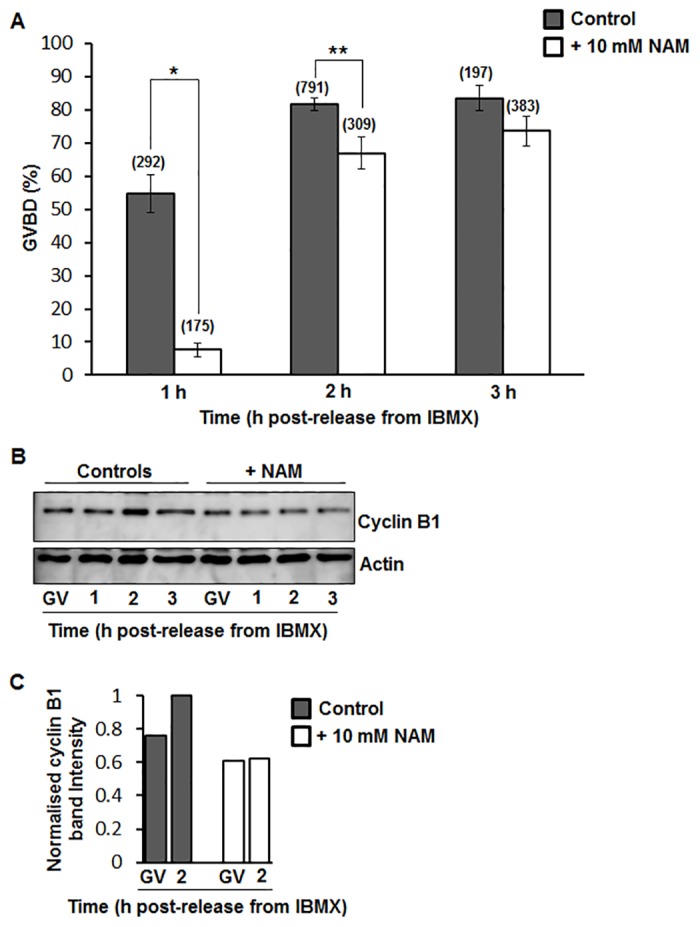
GVBD rates and cyclin B1 expression following release from IBMX.(A) Rates of GVBD were scored at 1, 2 and 3 h following release from IBMX in control untreated and NAM-treated oocytes (* P < 0.0001, ** P = 0.0011; Data are mean ± SEM; Analysis by Student’s t-test). Numbers of oocytes for each group are shown in parentheses and are pooled data from over 5 replicate experiments. (B) Western blot of cyclin B1 and actin at the GV-stage and at 1 h, 2 h and 3 h following release from IBMX (30 oocytes per sample; shown is a representative blot of 3 replicates). (C) Band intensities from Westerns were quantified and normalised against the intensity at 2 h post-release in control oocytes.